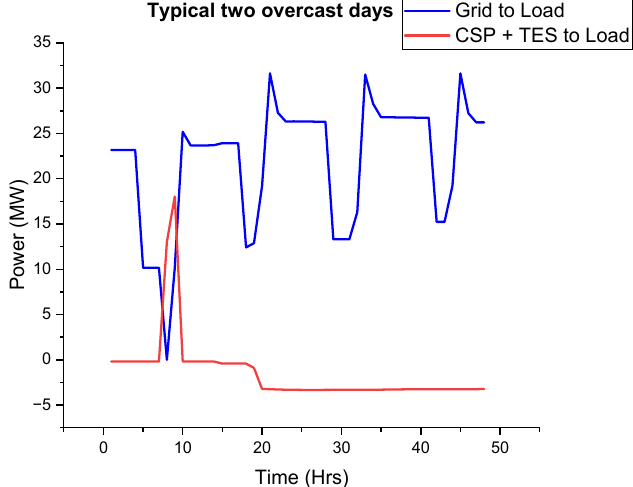
Figure 29. Two typical consecutive days with bad CSP production. Table 18. Economic performance indicators for the CSP and TES